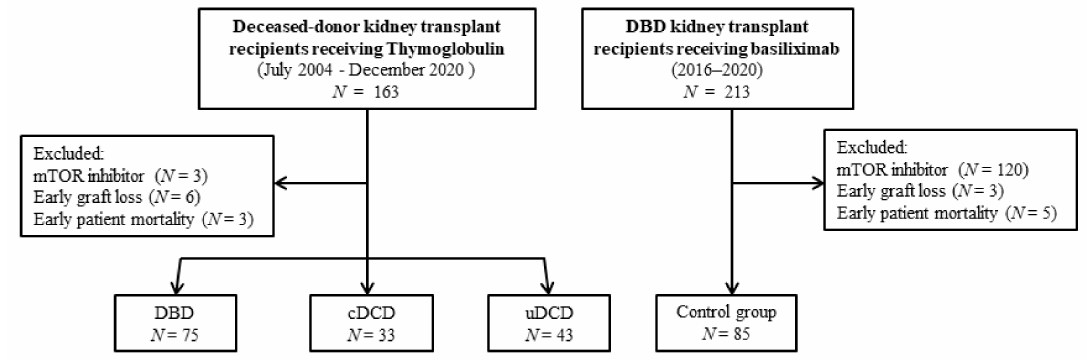
Figure 1. Patients’ flow-chart. DBD: brain death donors, cDCD: controlled after circulatory death donors, uDCD: uncon- trolled after circulatory death